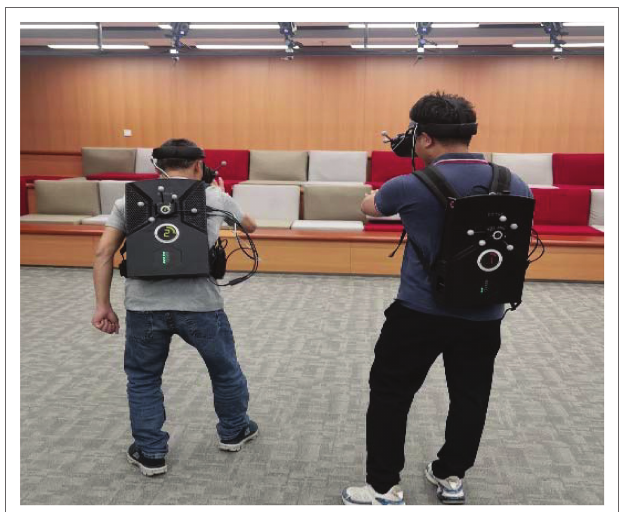
FIGURE 4 | Photos of students participating in the experiment.